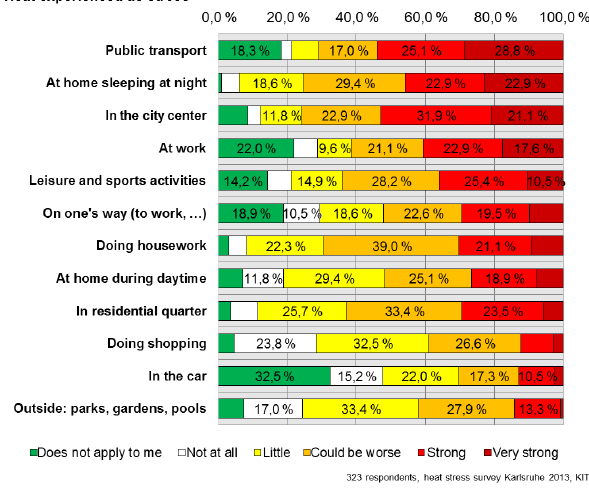
Figure 3. Box plots for subjective heat stress experienced in gen- eral, at home, and at work. Only economically active respondents and students/trainees answered the question on heat stress at work.